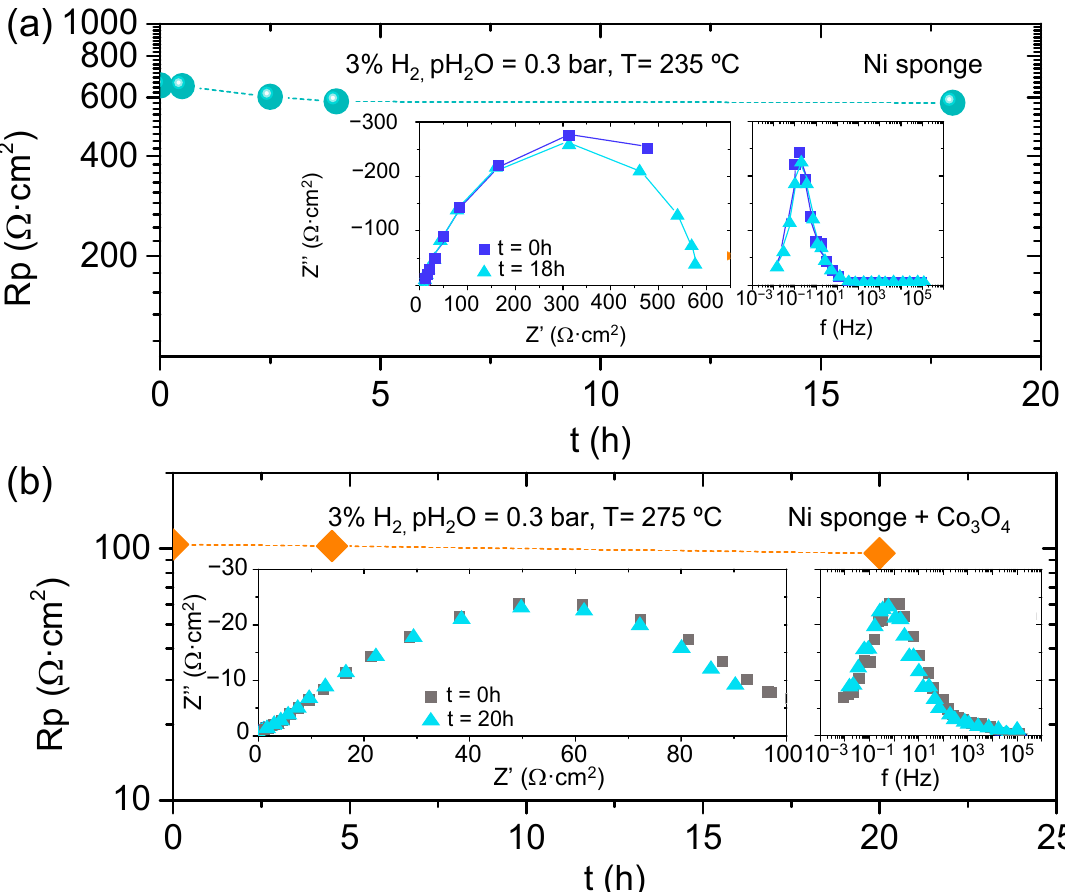
Figure 9. ( a ) Polarization resistance of Ni sponge/ CsH 2 PO 4 /Ni sponge cell as a function of time and Nyquist’s and Bode’s plots inset. ( b ) Polarization resistance of Ni sponge+Ni/CDP/Ni sponge+Ni cell as function of time and Nyquist’s and Bode’s plots of Ni sponge+Co 3 O 4 /CDP/Ni sponge+ Co 3 O 4 cell.